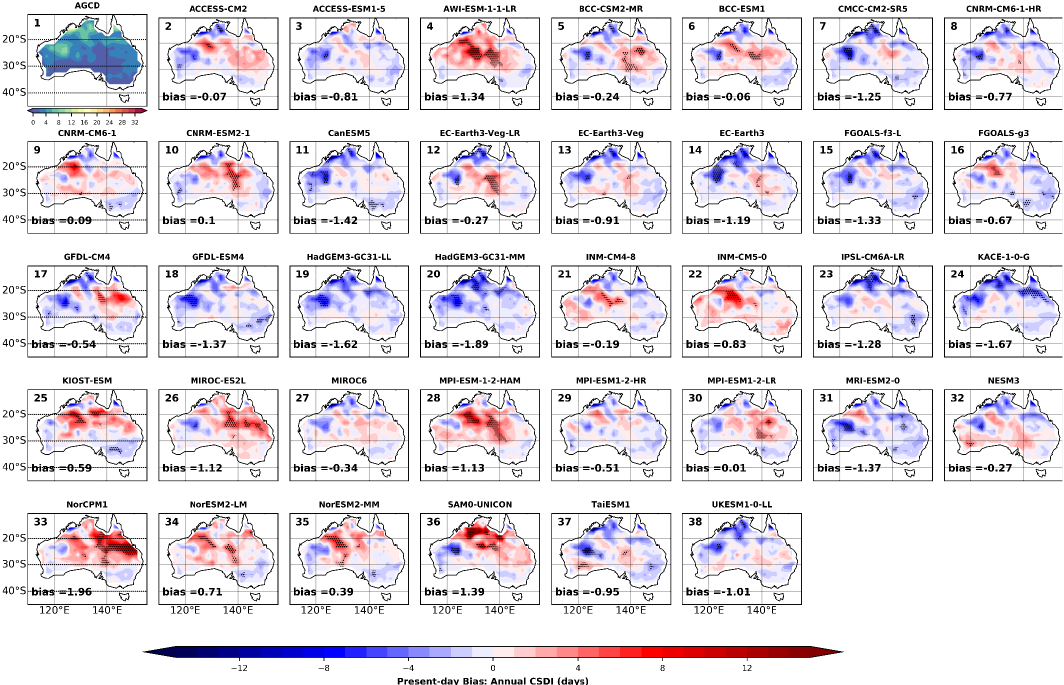
Figure 11. Climatological mean annual bias in the annual count of nights with at least 4 consecutive nights when daily minimum temperature < 10th percentile (CSDI: days) relative to Australian Gridded Climate Data dataset (AGCD; panel 1 ), for the individual CMIP6 GCMs (panels 2 – 38 ). Data spans 1951–2014. Stippling indicates statistically significant differences using a student’s t-test at the 95% confidence level.